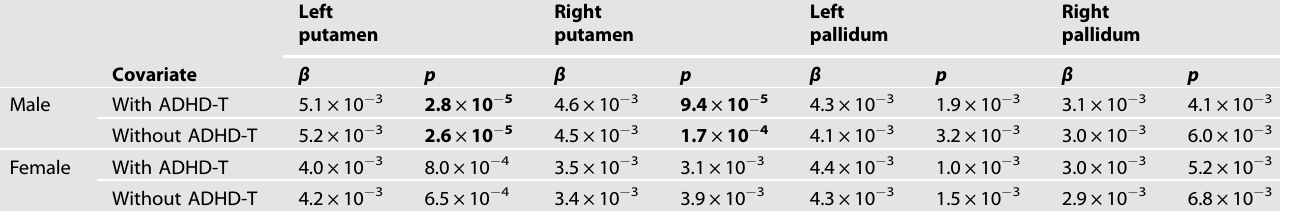
Table 1. Associations between GMVs and major allele C of rs945270 in males and females. Left Right Left Right putamen putamen pallidum pallidum Covariate β p β p β p β p Male With ADHD-T 5.1 × 10 − 3 Female With ADHD-T 4.0 × 10 − 3 8.0 × 10 − 4 Without ADHD-T 4.2 × 10 − 3 Bold: p < α = 2.1 ×10 − 4 . Other nominal associations with p < 0.05 are listed in Supplementary Table